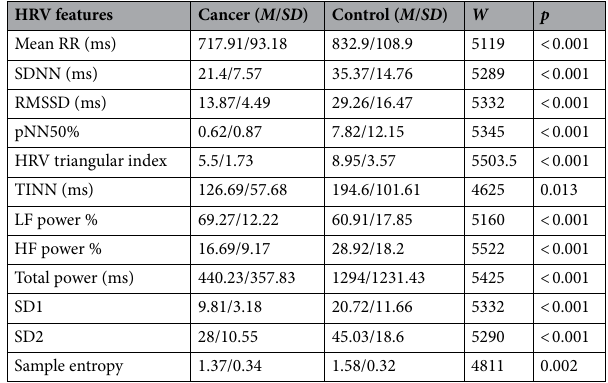
Table 3. HRV features comparison between cancer and control individuals.